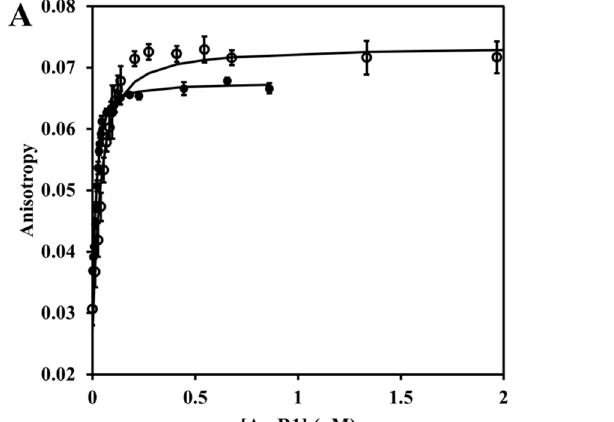
Figure 9. ArsR binding to DNA labelled by fluorescence probe. Titration was conducted in 10 mM MOPS/0.1 M NaCl/15% glycerol, pH 7.0 at 30 °C. Panel ( A ), 25 nM concentration of PDNA1 (•) or PDNA2 ( ◦ ) was titrated with the indicated concentrations of the recombinant protein ArsR1 protein. Panel ( B ), 25 nM concentration of PDNA1 ( ▫ ) or PDNA2 ( ▪ ) was titrated with the indicated concen- trations of the recombinant ArsR2 protein. Solid lines represent the best fit of the data to Equation (5). The fitted parameters are presented in the main text. Each data point is a mean of ten determi- nations ± SD.